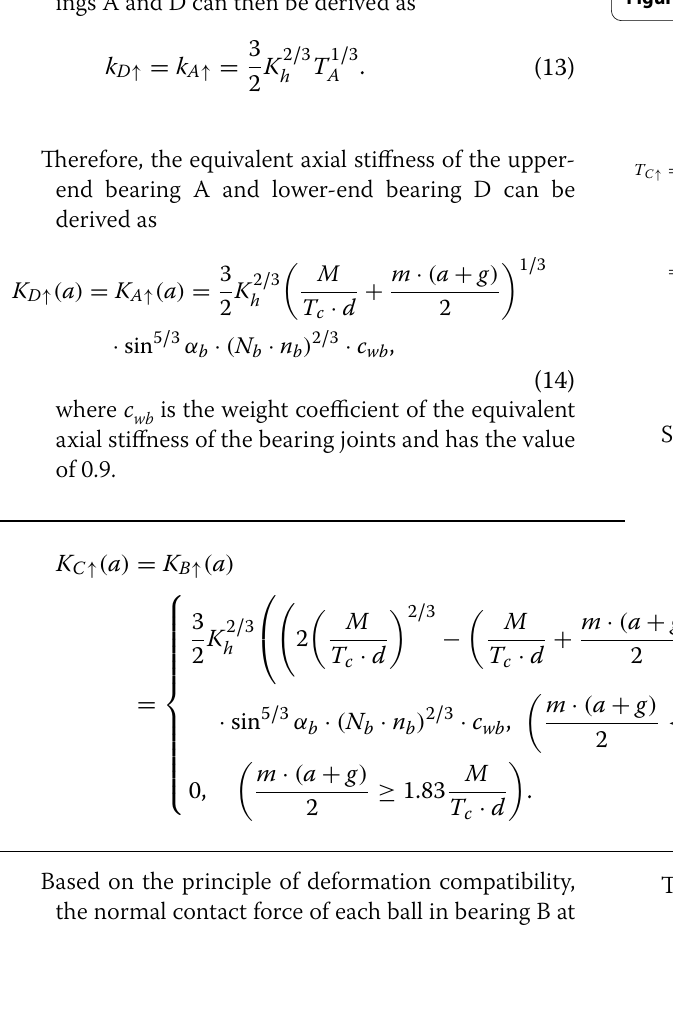
Figure 6 Force diagram of bearing joints under upward